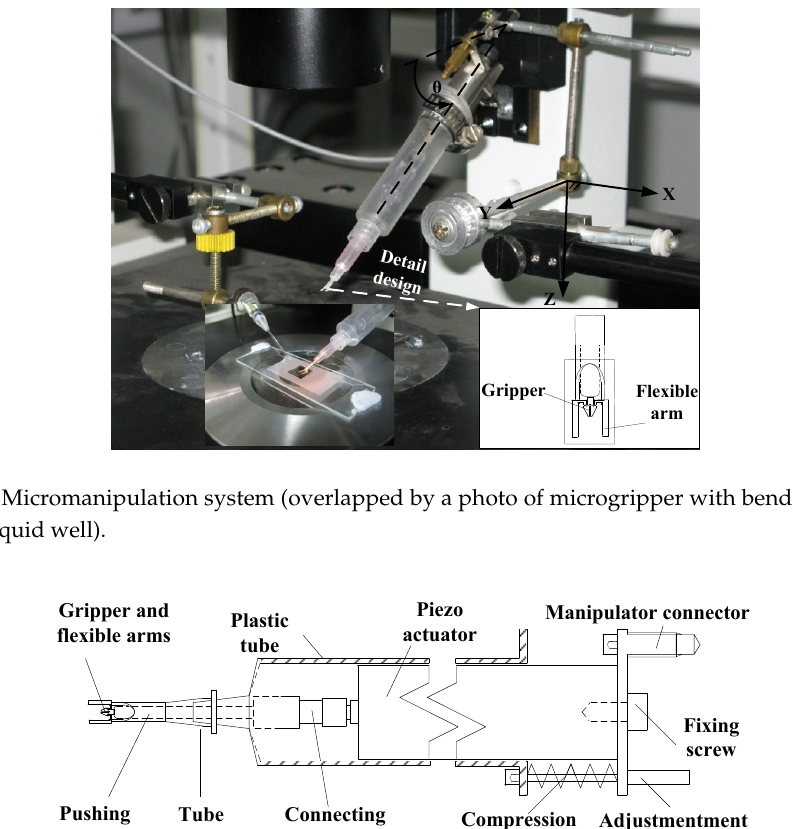
Figure 2. Detail components and assembly of Gripper and Actuator Mechanism.